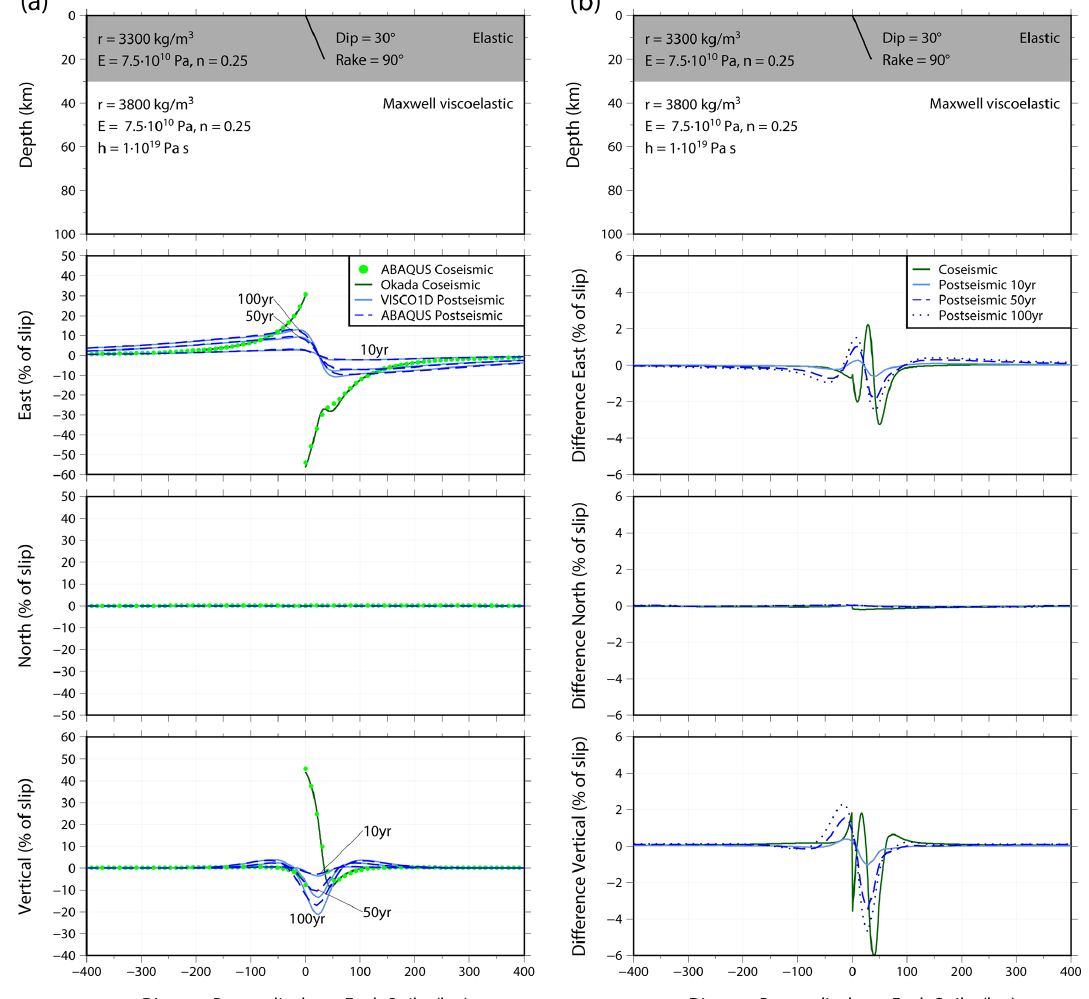
Figure 4. As for Fig. 3 but for a 30 ◦ dipping reverse